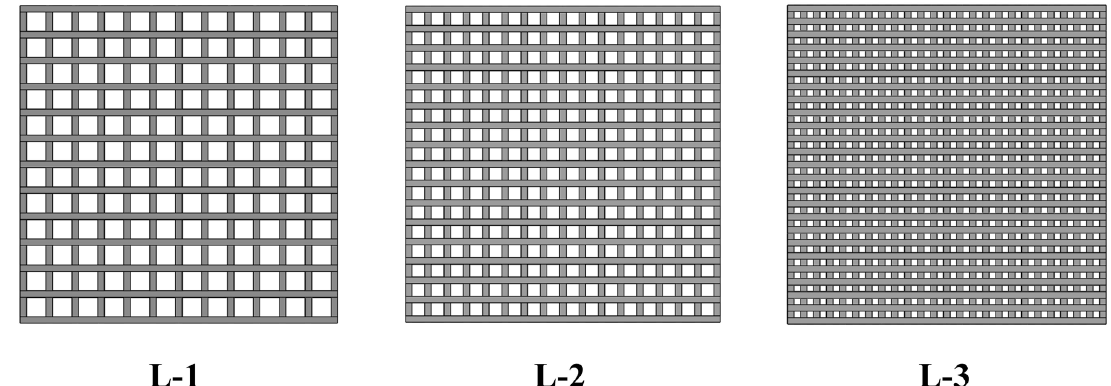
Figure 6. Plane diagrams of specimens with different strut